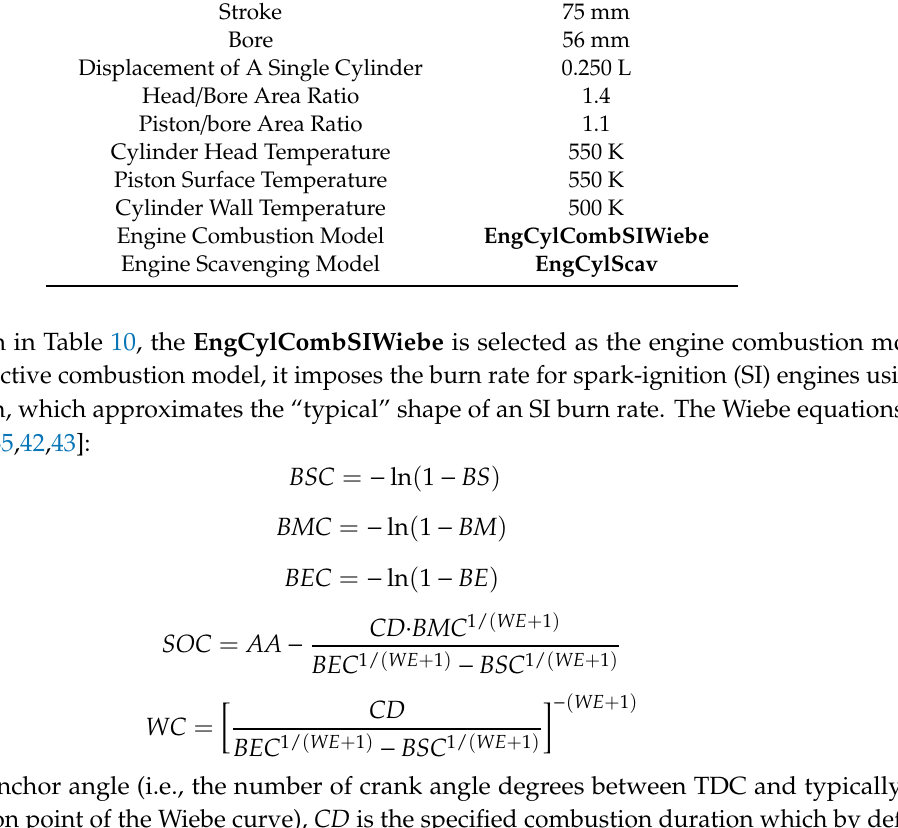
Table 10. Parameter settings of the simulation module of cylinder.